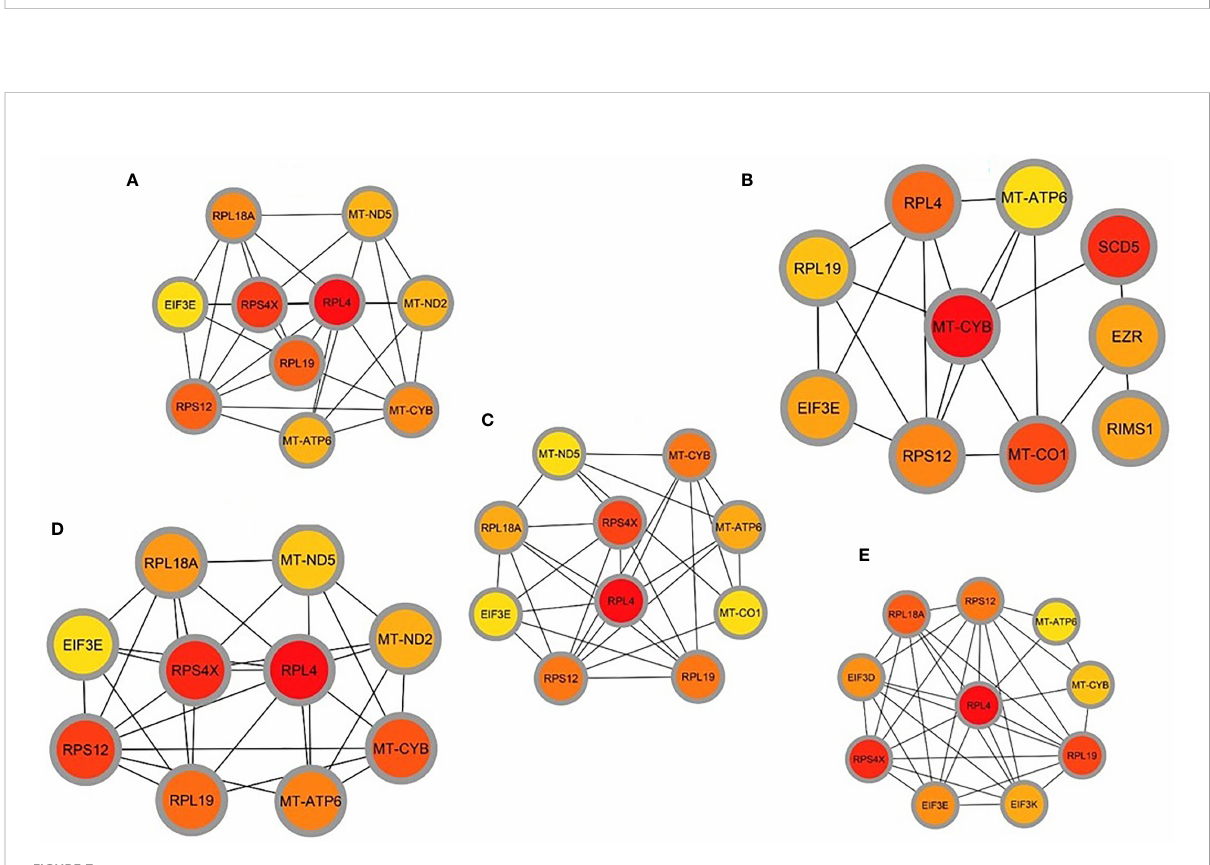
FIGURE 7 Determination of hub genes from the protein-protein interaction (PPI) network by using the Cytohubba plugin in Cytoscape. We applied fi ve algorithms of the Cytohubba plugin to obtain the hub genes. Here (A) maximum neighborhood component (MNC), (B) betweenness, (C) degree, (D) edge percolated component (EPC), and (E) maximal clique centrality (MCC). Red to yellow color gradients indicate the higher ranking of hub